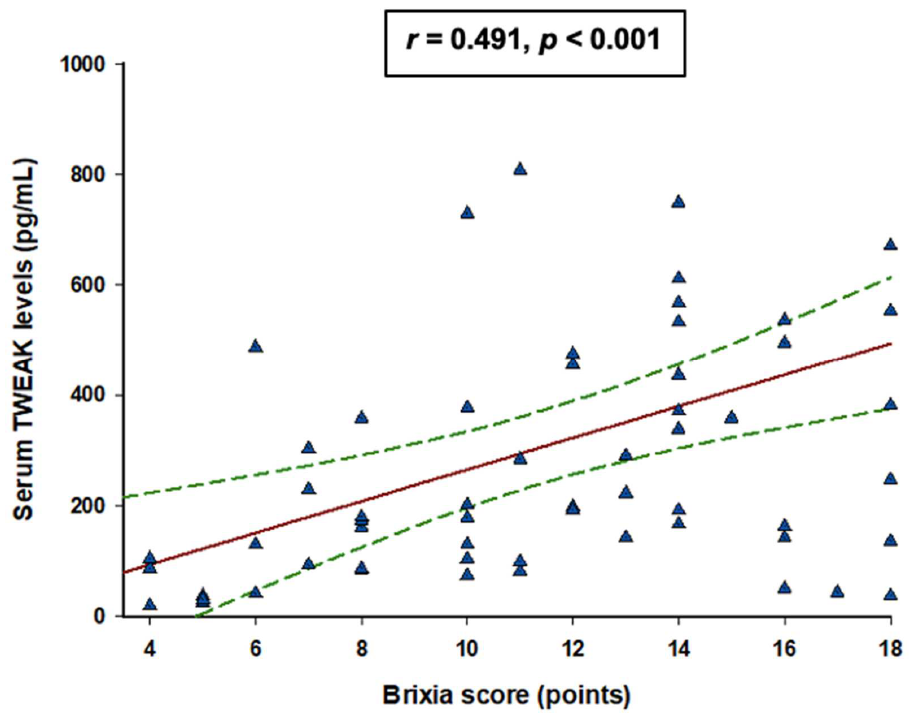
Figure 2. Spearman rank correlation analysis between Brixia score and serum TWEAK levels. The red line represents a correlation line, the dotted green lines represent 95% confidence interval, and blue triangles represent values from respective patients. Table 3. Correlation between serum TWEAK levels at admission to ICU and variables of interest.